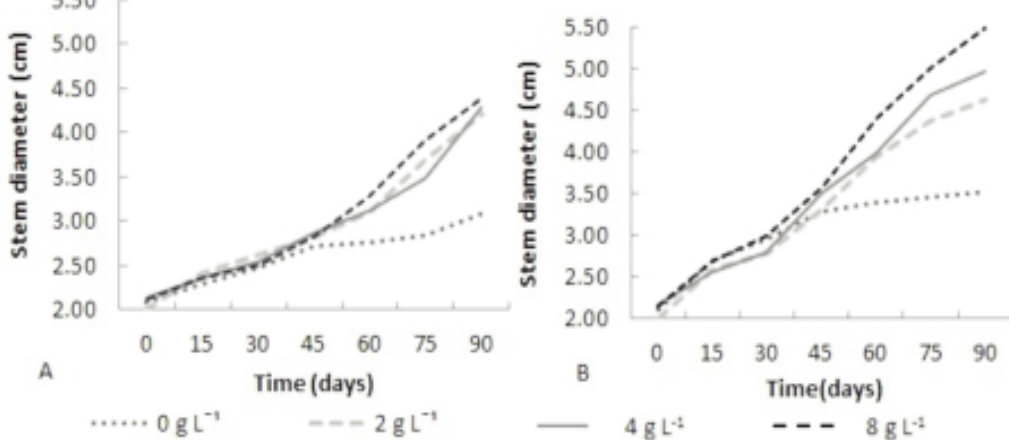
Fig. 5 ­ Increase of stem diameter, over time, of peach plants cv. Capdeboscq, in relation to the dose of the CRF and two cultivation envi­ ronments (A) Open air and (B)